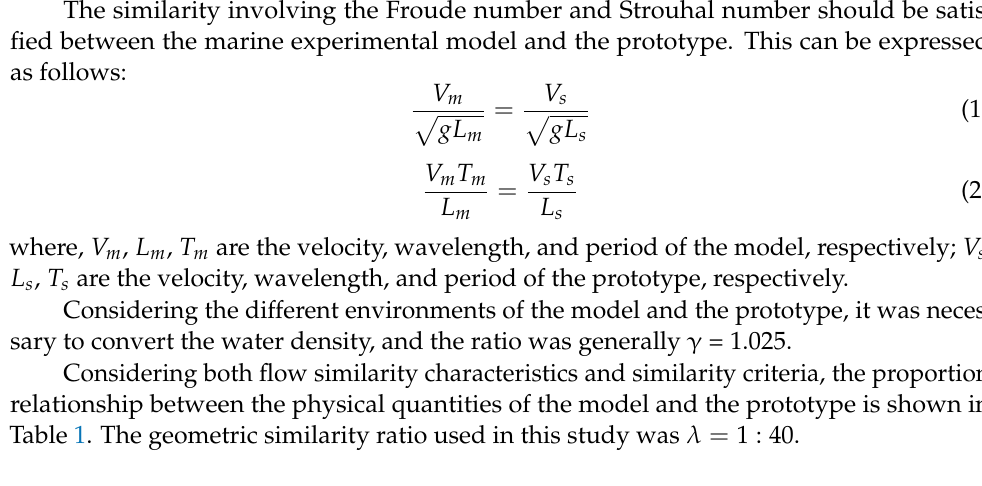
Table 1. Proportional relationship between model and